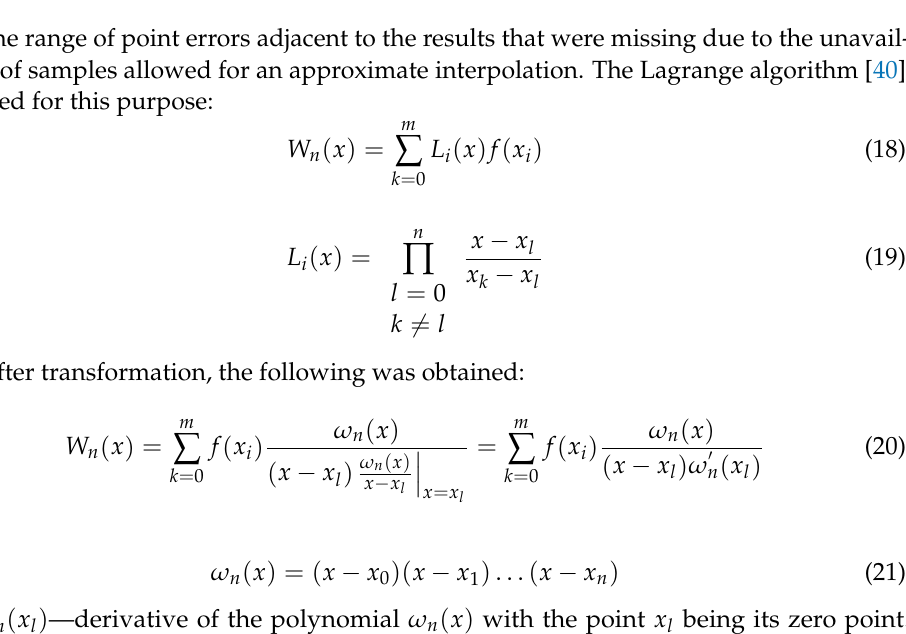
Figure 9. Coefficient of friction values of samples obtained from 4th brake pad group.